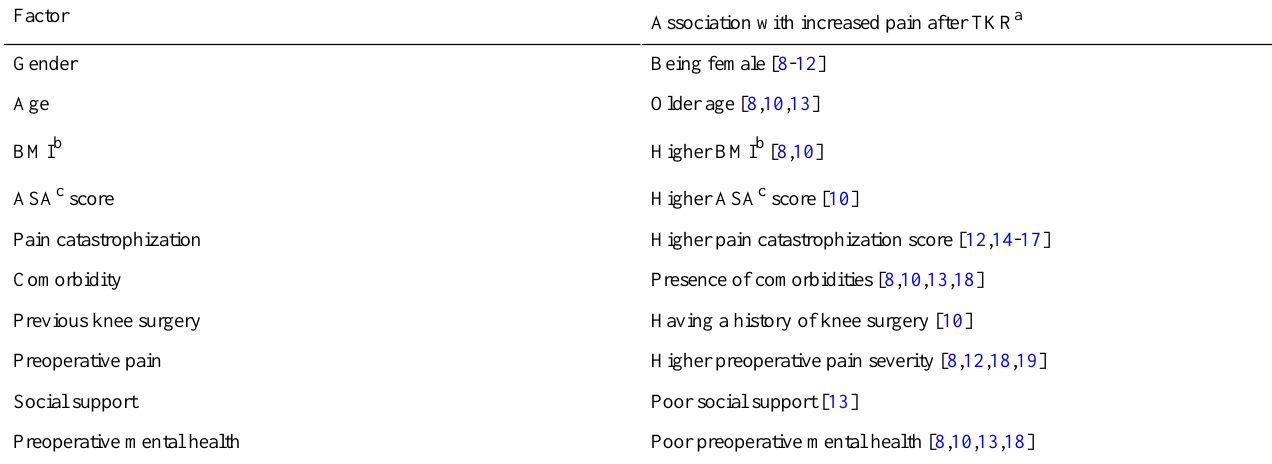
Table 1. Factors associated with increased pain after total knee